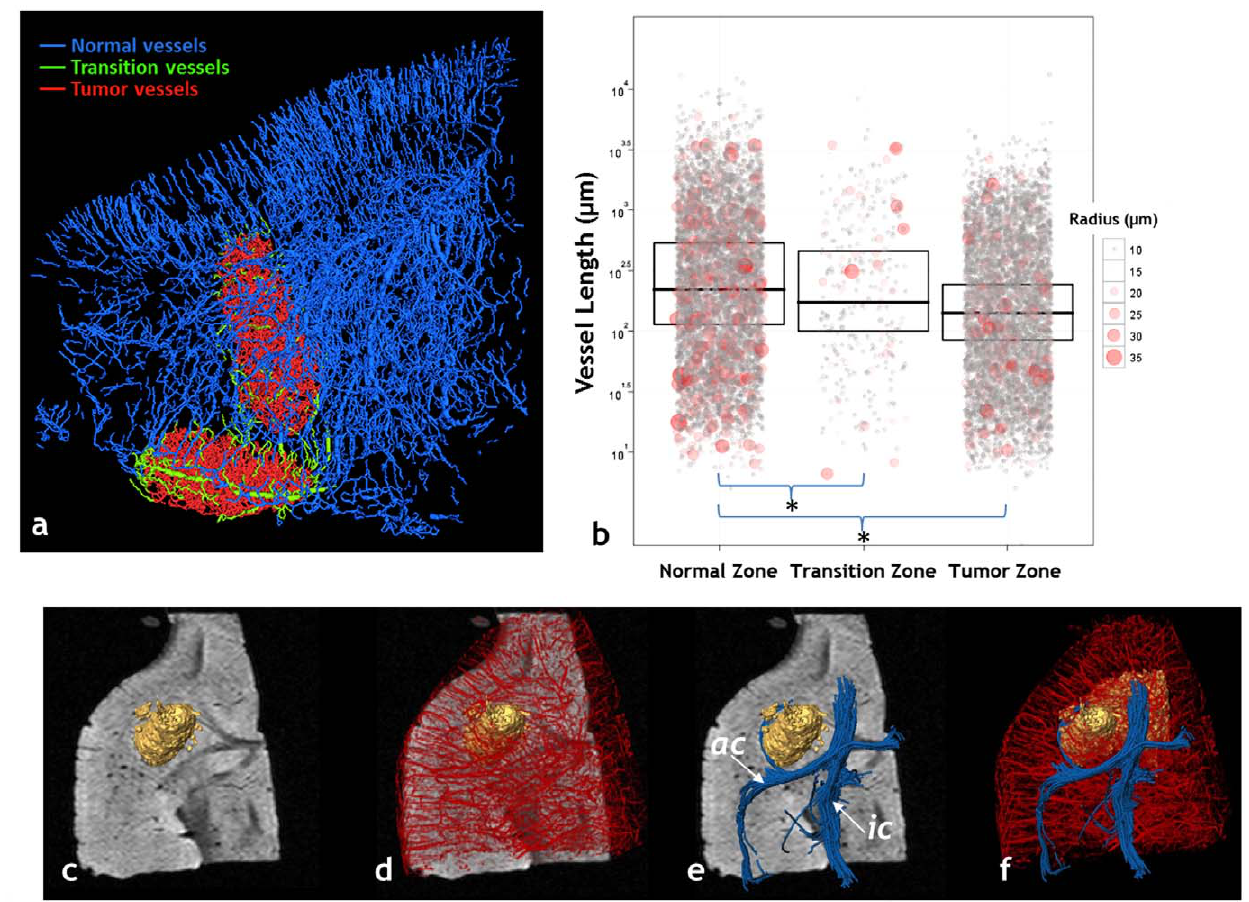
Figure 3. Ultra-high resolution 3D m MRI and ‘‘zonal’’ analyses of the neurovasculature. (a) 3D rendering of the neurovasculature in a non- invasive, 9L tumor bearing mouse brain acquired using ultra-high resolution (30 m m 6 30 m m 6 30 m m) m MRI. The vasculature has been color coded into three different ‘‘zones’’: normal vessels (blue), tumor vessels (red) and vessels at the tumor-brain interface or transition zone (green). The transition-zone or tumor-brain tissue interface is crucial to understanding both, brain tumor angiogenesis and invasion. The radius and length of every individual vessel segment was measured in each zone. (b) Box plot of the average vessel length in each zone, wherein the width of each box includes 75% of the measured lengths and the median length is indicated by a horizontal line in each box. In addition, the radius of every vessel segment is plotted for each zone, with the color and size of each symbol proportional to the vessel radius. The normal zone exhibited significantly longer vessel segments compare to the transition (p=0.002) and tumor zones (p , 0.001), respectively. At this tumor stage, vessel radii were similar between the tumor and normal zones. These data demonstrate our ability to characterize the neurovasculature in physiologically relevant ‘‘zones’’, and could provide new insight into the relationship between brain tumor angiogenesis and invasion. (c) T 2 -weighted m MRI slice through a 9L brain tumor (gold rendering) bearing brain. (d) 3D overlay of the neurovasculature acquired using ultra-high resolution m MRI. (e) 3D DTI image showing reorganization of the fibers of the anterior commissure ( ac ) and internal capsule ( ic ) around the tumor. (f) Overlay of (d) and (e) illustrating simultaneous changes in vascular and white matter structures.